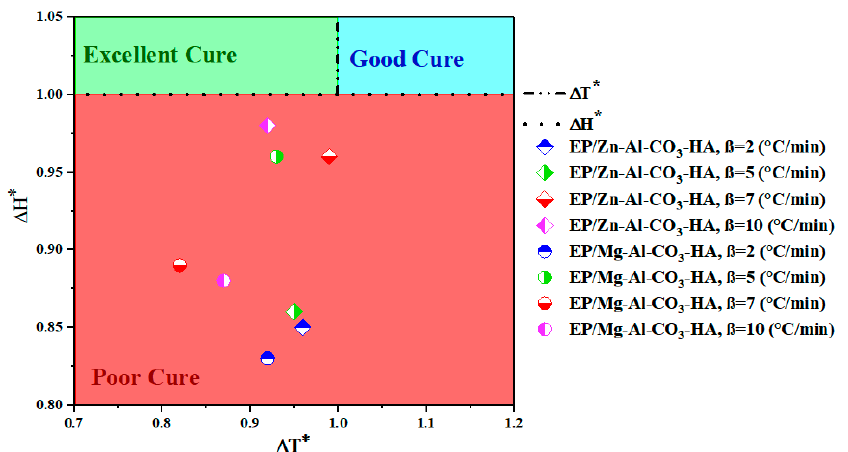
Figure 6. Cure state of the EP/Zn-Al-CO 3 -HA and EP/Mg-Al-CO 3 -HA nanocomposites at different heating